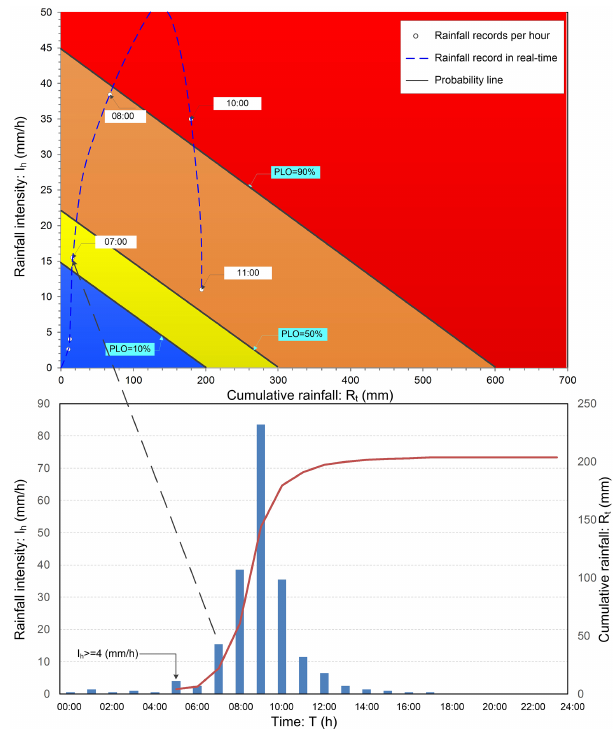
Figure 6. Application of the methodology in the Huangshan re- gion (rainstorm of 30 June